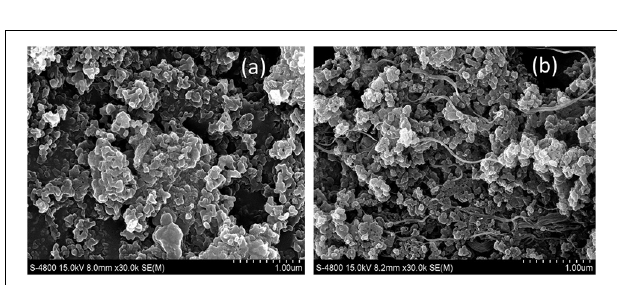
FIGURE 6 | Field emission scanning electron microscopy (FESEM) images of (a) pristine Ni 3 BTC 2 and (b) composite of Ni 3 BTC 2 /OH-SWNTs.